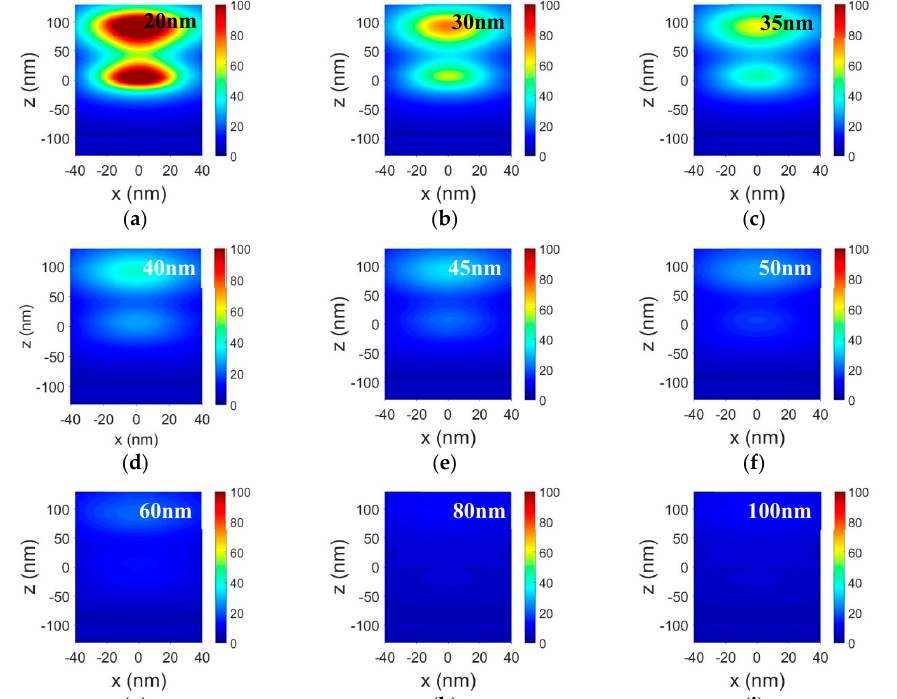
Figure 10. The electric field E(x, z) distributions of the silver nanorod on the SiO 2 substrate with a diameter of 30 nm and a length of 100 nm for the incident dipole source with the z-polarization direction. ( a – i ) Correspond to the monitor positions of y = 20, 30, 35, 40, 45, 50, 60, 80, and 100 nm. Crystals 2020 , 10 , x FOR PEER REVIEW